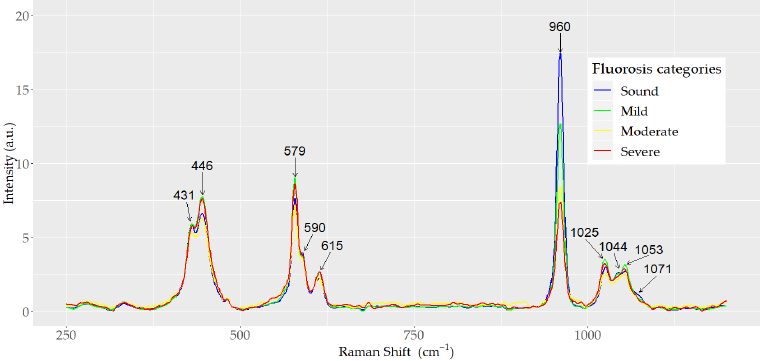
Figure 2. Mean normalized Raman spectra of sound, mild, moderate, and severe dental fluorosis categories.